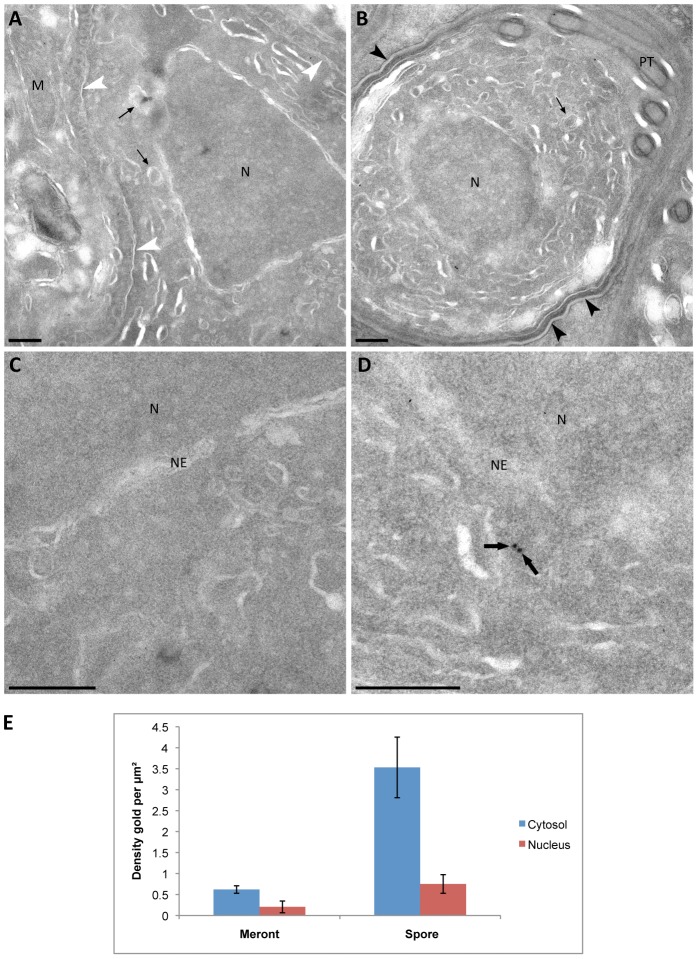
Quantitative immunoloelectron microscopy of the glycolytic enzyme phosphoglycerate kinase (PGK-3) in thawed cryosections of T. hominis meronts and spores.Cryosections of T. hominis labelled with anti-PGK-3 antiserum were sampled with micrographs taken at systematic uniform random (SUR) locations. The micrographs presented in the figure are representative of the quantitative data. (A) T. hominis in proliferative meront phase. White arrowheads indicate the plasma membrane of the parasite. (B) T. hominis early spore stage. Black arrowheads indicate the forming cell wall. (C) and (D) Enlarged image details from micrographs (A) and (B) respectively, demonstrating the difference in immunolabelling. In enlargement (D), PGK-3 labelling inside the cytosol can be seen (see black arrows). M = mitochondrion of the host rabbit kidney cell; Small arrows = mitosomes; PT = polar tube; N = nucleus; NE = nuclear envelope; bars = 200 nm. (E) Mean densities of PGK-3 gold labelling from three individual experiments. The area of compartments in T. hominis meronts and spore stages was estimated using point counting (see Materials and Methods) and counts of 10 nm gold made (n = 44 micrographs for spores, n = 51 micrographs for meronts; mean point counts were 92/experiment and mean gold counts 56/experiment). Error bars indicate the standard error of the mean.